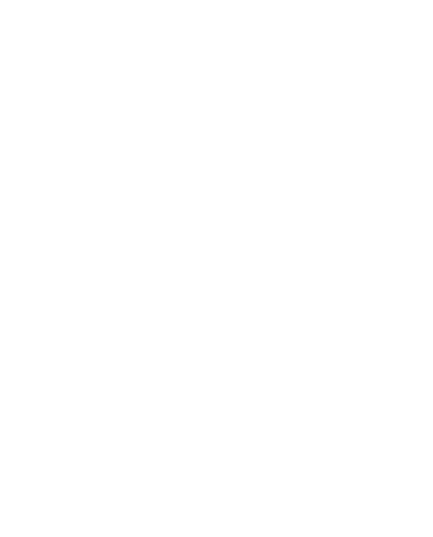
Table 5. PRE using simulated data